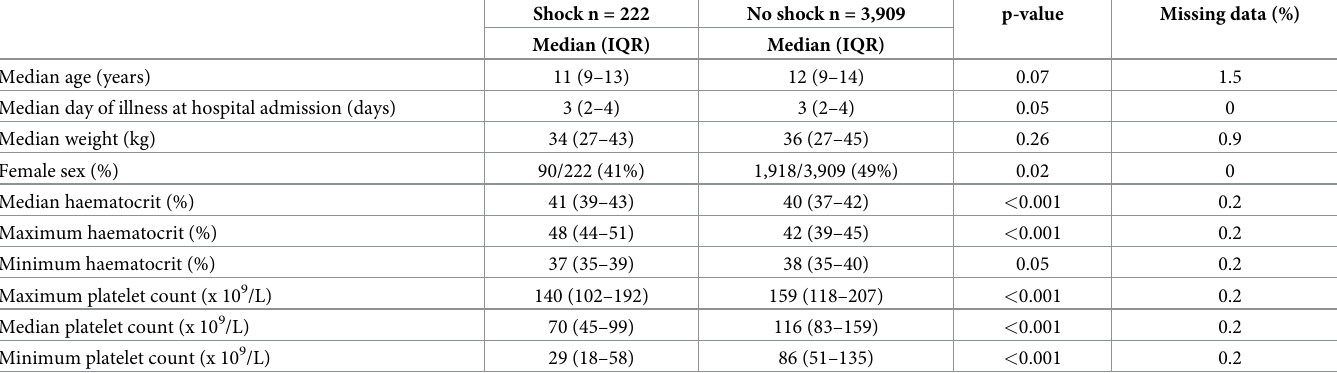
Table 2. Characteristics of cohort (n = 4,131) divided by complication outcome during hospital. Haematological values and ranges refer to results taken over the initial 48 hours of hospitalisation only. Data is presented as median and brackets denote the interquartile range. Univariate analyses were done using the Mann-Whitney test or Chi Squared test as appropriate.